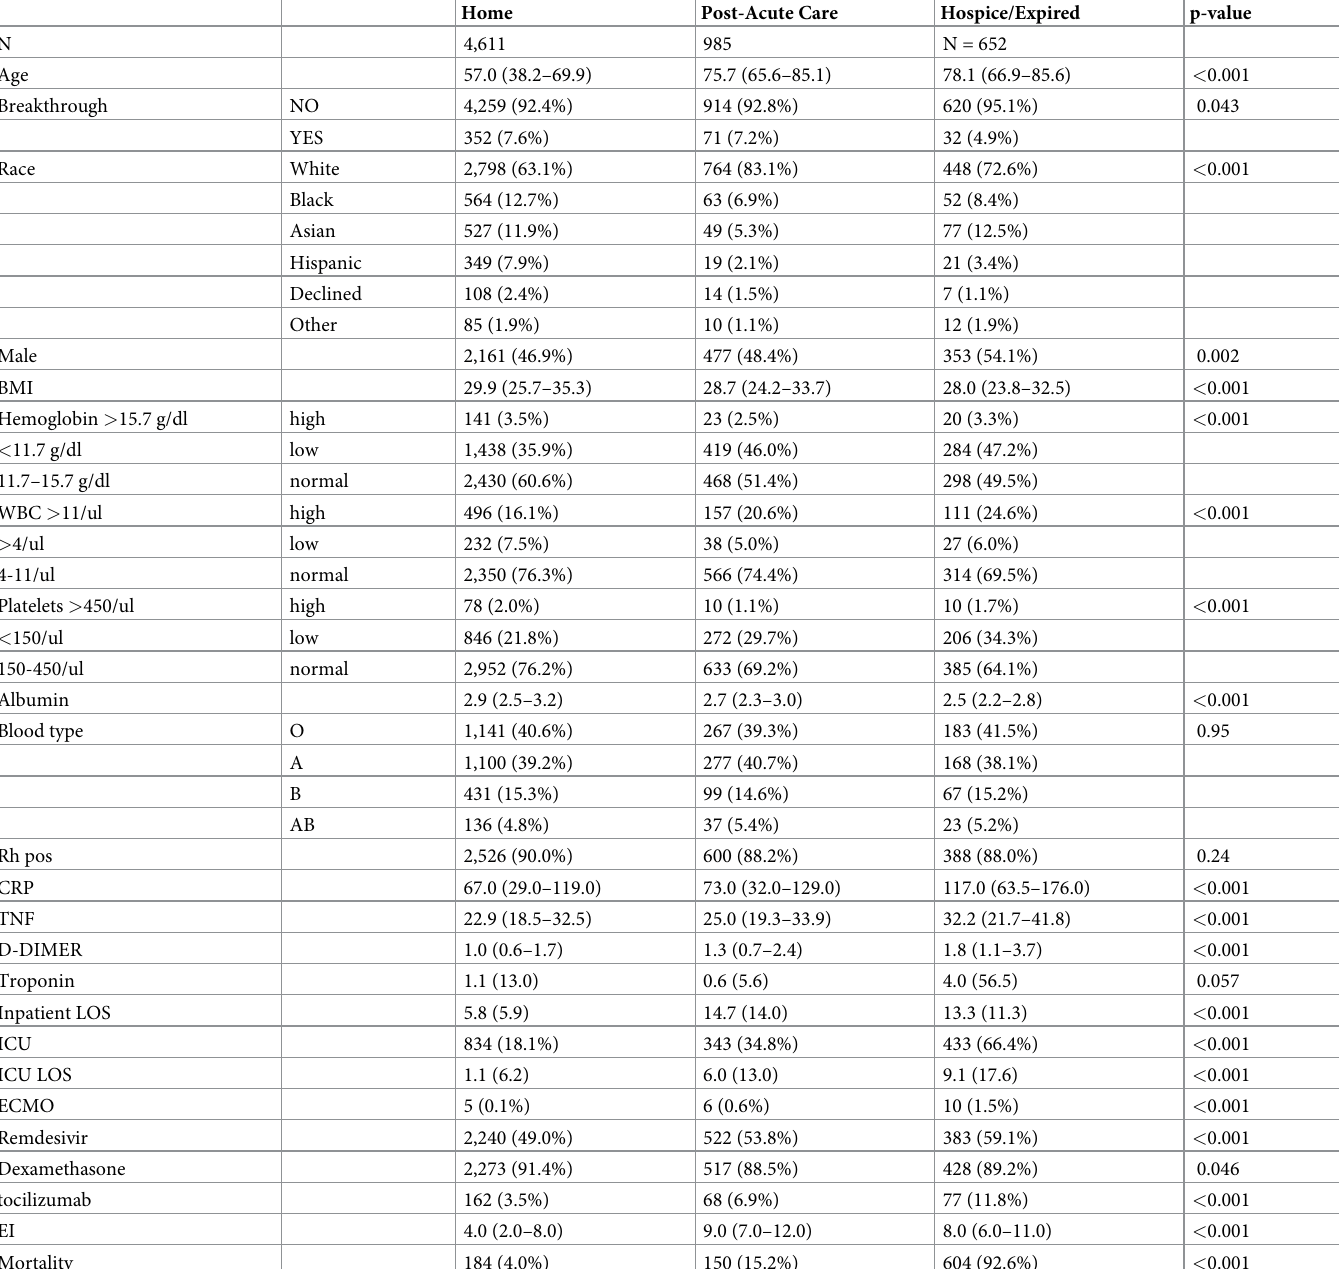
Table 1. Demographics and characteristics of patients admitted with COVID-19 based on discharge disposition. Categorical variables expressed as count and per- centage, and continuous variables as median and IQR.